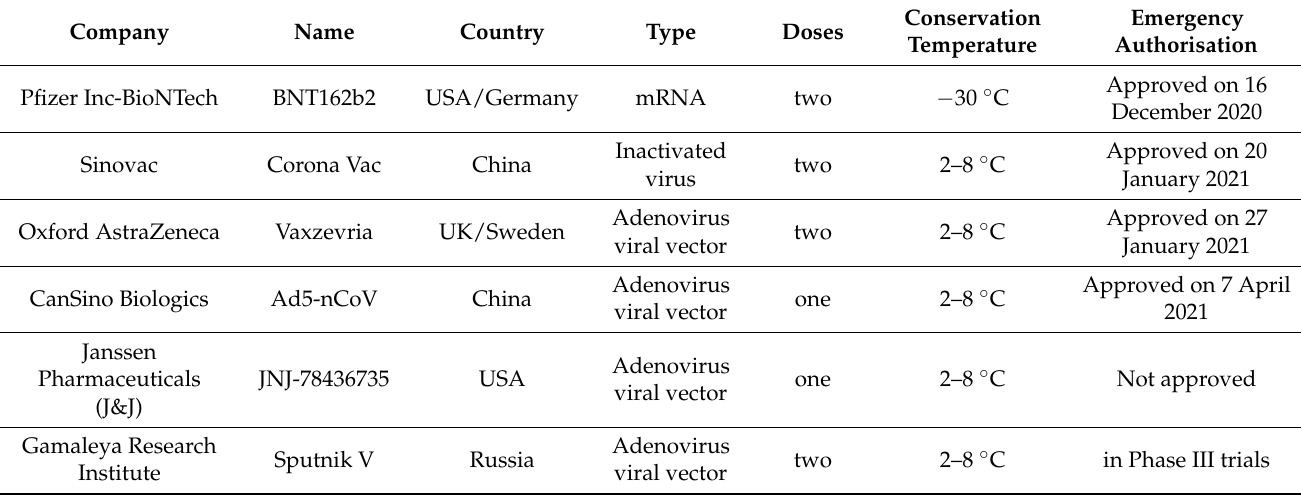
Table 1. Characteristics of type of vaccines available and approved for emergency use or on Phase III trials in Chile, as of 30 April